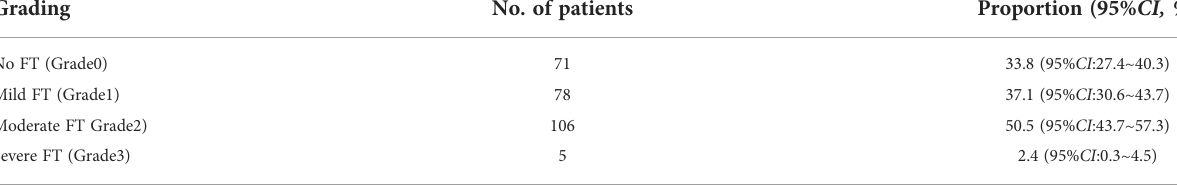
TABLE 2 Distribution of fi nancial toxicity in patients with nasopharyngeal carcinoma (N=210). Grading No. of